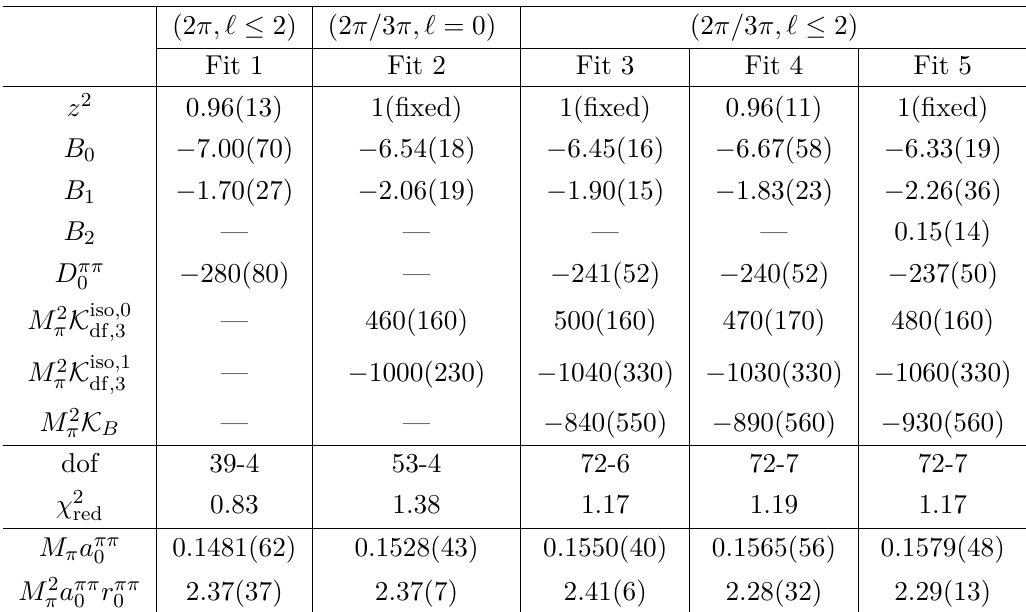
Table 5. Fit results for pions on the N200 ensemble using M π L = 4 . 419849 , with notation as in table 4. Each fit contains all 2 π + and 3 π + energy levels (in the appropriate irreps) below E ∗ = 4 M π and E ∗ = 5 M π , max 2 , max